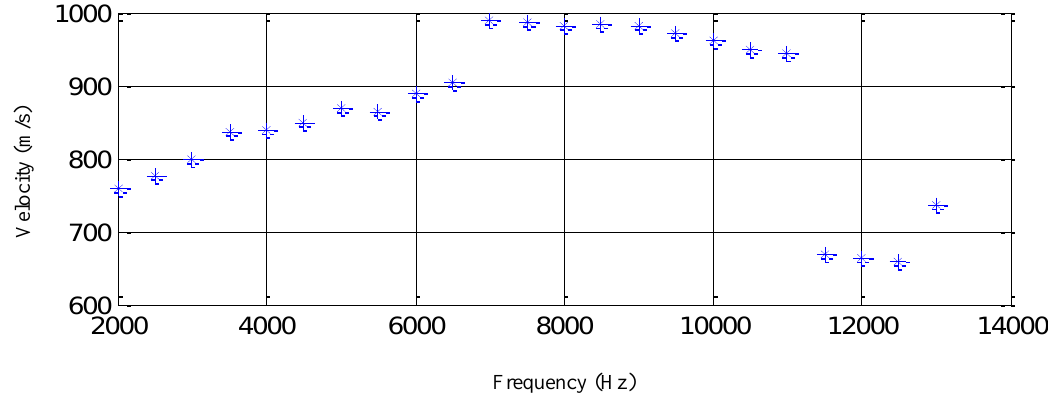
Figure 11. The averaged group velocity measuring results of different central